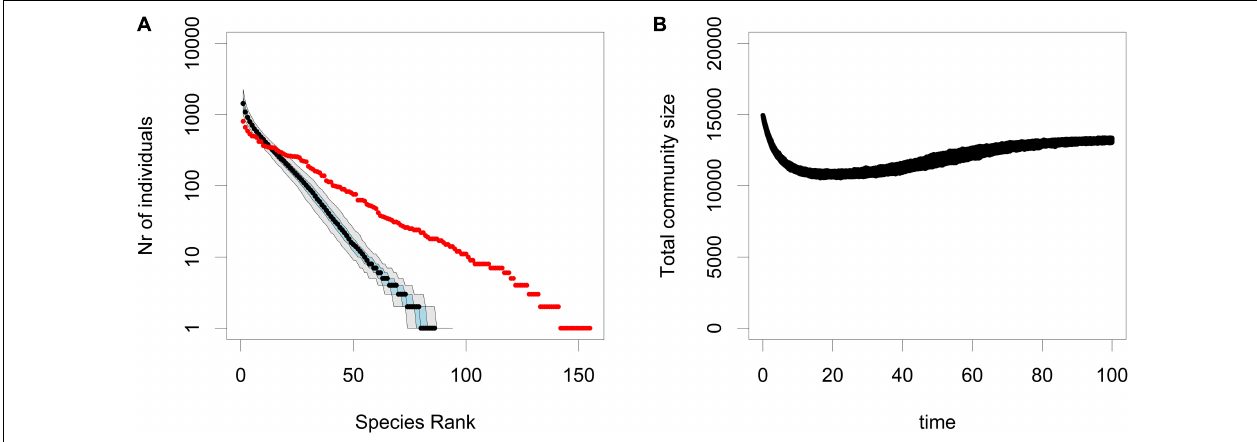
FIGURE 5 | The RAC (A) and the total community size (B) for simulations of the CWR model where the strict conditions of CWR are relaxed and reflect a scenario where the net growth rate of the residents is positive, yet still lower than that of the mutants. This causes a selective sweep during which the residents are replaced by the mutants, because the mutants have a higher fitness. In the RAC plot the median is shown in black, the 25th and the 75th percentile are shown in blue and the 5th and the 95th percentile are shown in gray, and the input community is plotted in red. These plots are based on 500 simulations. The parameters used were b 0 , res = 0.3, b 0 , mut = 0.6, d = 0.1, K = 16000 and µ =